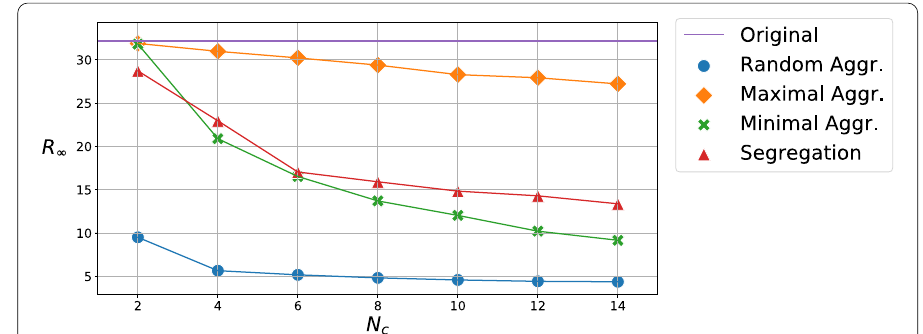
Fig. 5 Final fraction of recovered agents R ∞ for the considered strategies as a function of the number of colors N c . The purple line represent the corresponding value for the original case with no color. Error bars are not plotted for being